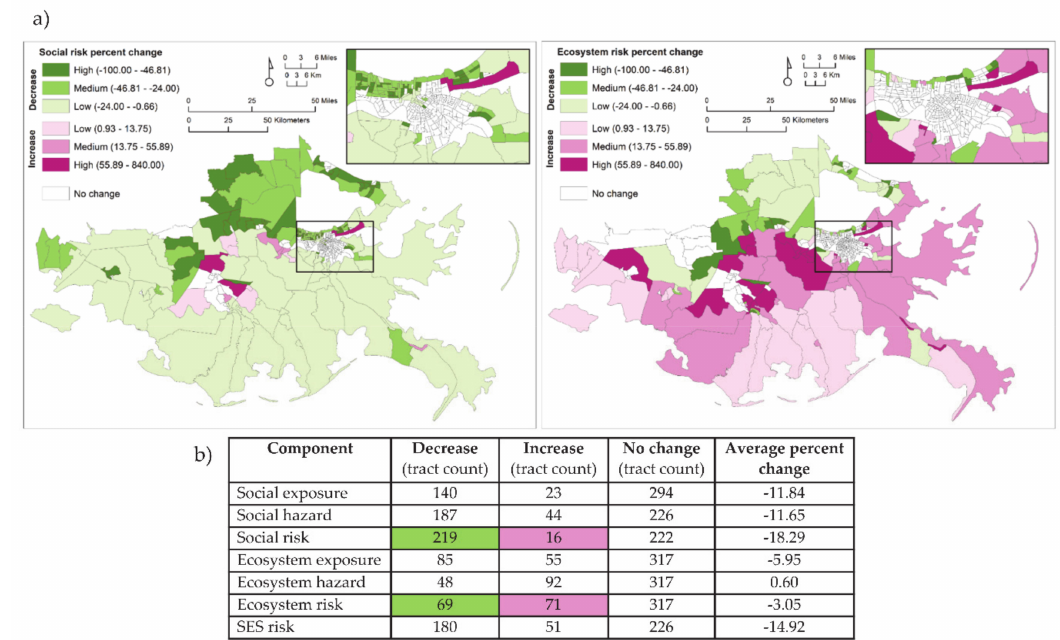
Figure 6. Percentage change in future social ( left ) and ecosystem ( right ) risk scores per tract in 2025. Darker shades of green indicate greater decreases in risk and darker shades of pink indicate greater increases in risk ( a ). The number of tracts in the delta that decrease, increase, or do not change in risk and risk component scores, as well as corresponding average percent change are also shown ( b ). The mapped elements in ( a ) are colored in the table ( b ) according to decreases in risk (green) and increases in risk